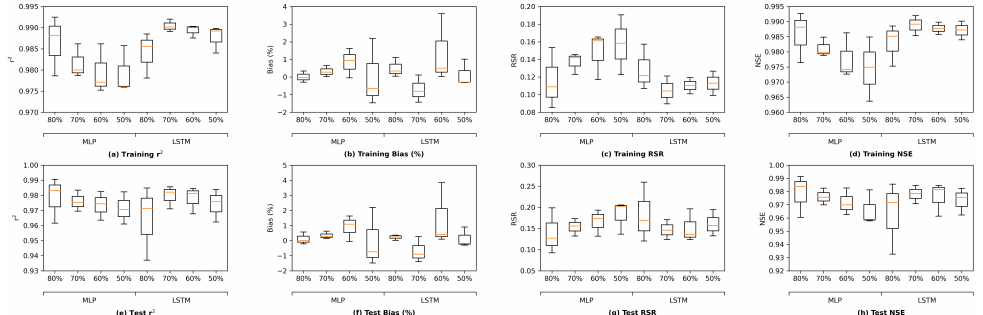
Figure A12. Box and whisker plots of four types of metrics consisting of r 2 , percent bias, RSR, and NSE on stations belonging to the northern Delta group during the training (panels ( a – d )) and test (panels ( e – h )) phases of the grouped (G) MLP and LSTM models under four scenarios with varying lengths of training data: 50%, 60%, 70%, and 80% of all the data available.